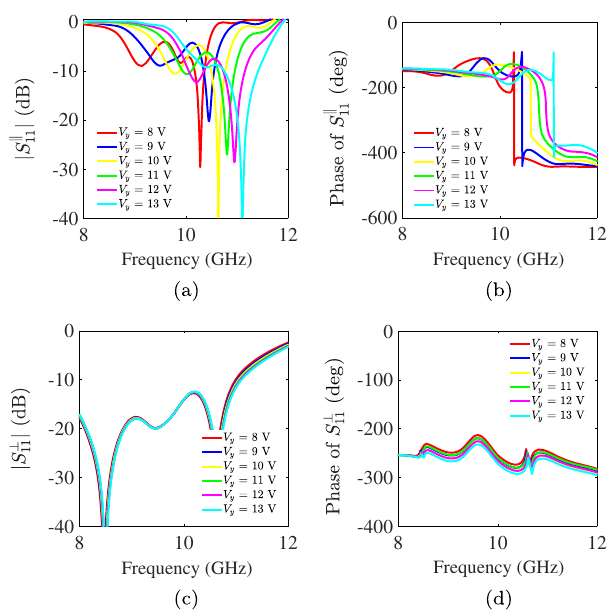
FIG. 23. Measured reflection coefficient entries for the bire- fringent board. (a) Amplitude and (b) phase of the reflection coefficients for the parallel polarization. (c) Amplitude and (d) phase of the reflection coefficients for the perpendicular